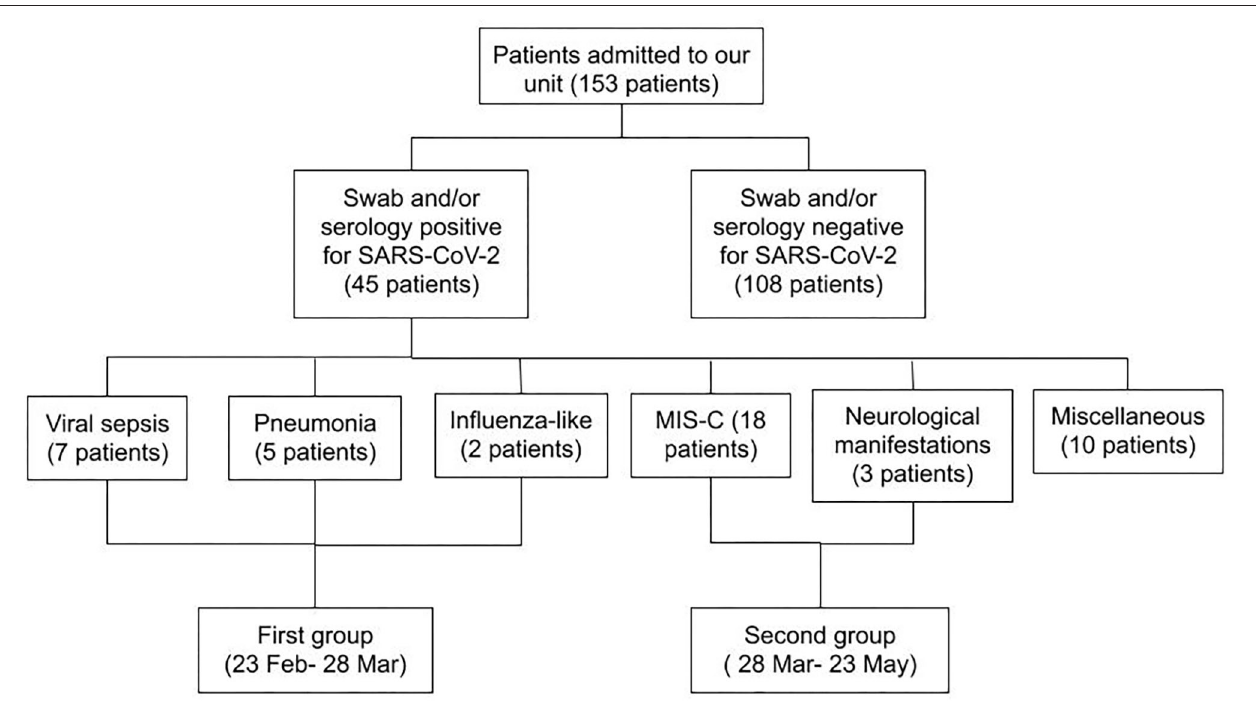
FIGURE 4 | Flow chart showing the features of all patients admitted during the study period. A first differentiation was made based on swab and serology results for SARS-CoV-2. Patients with a positive result of one or both tests were divided according to the pattern and the timing of presentation.